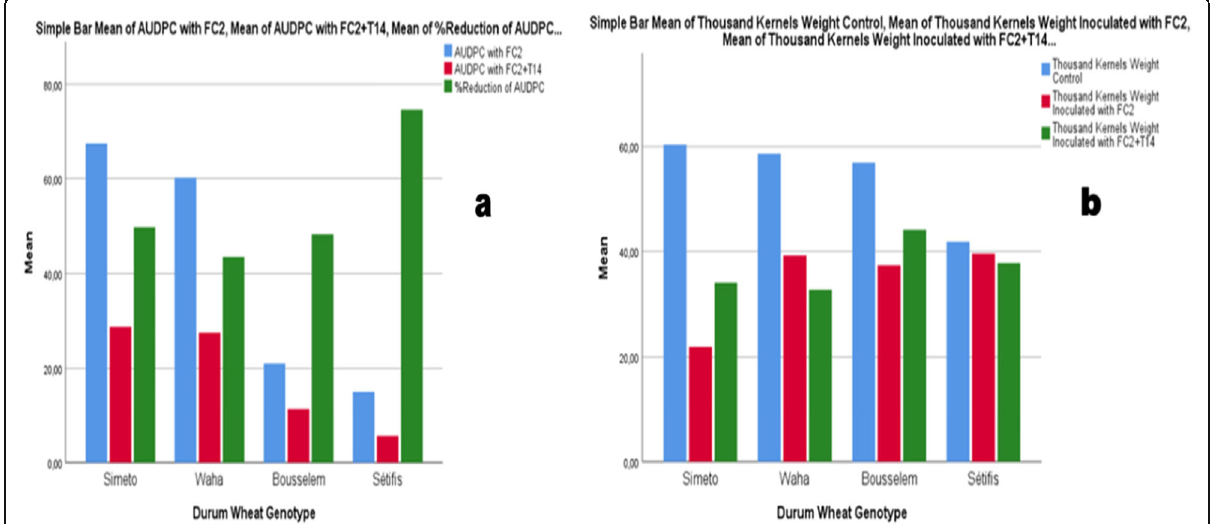
Fig. 5 Biocontrol effect of T14 on wheat FHB symptoms on the 4 cultivars tested. a On AUDPC standard. b On thousand kernels weight TKW